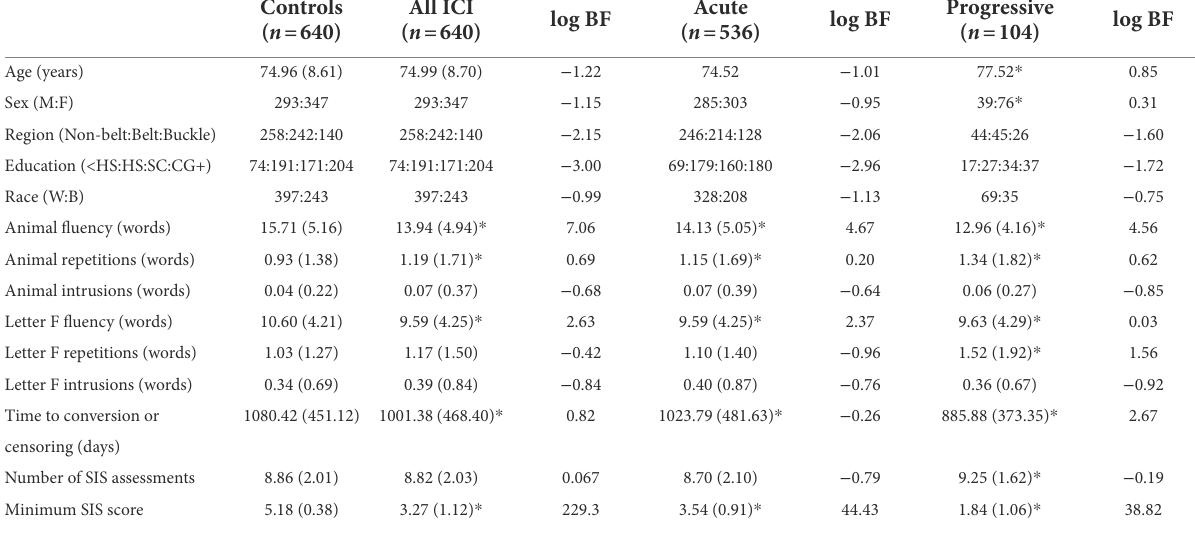
TABLE 1 REGARDS participant